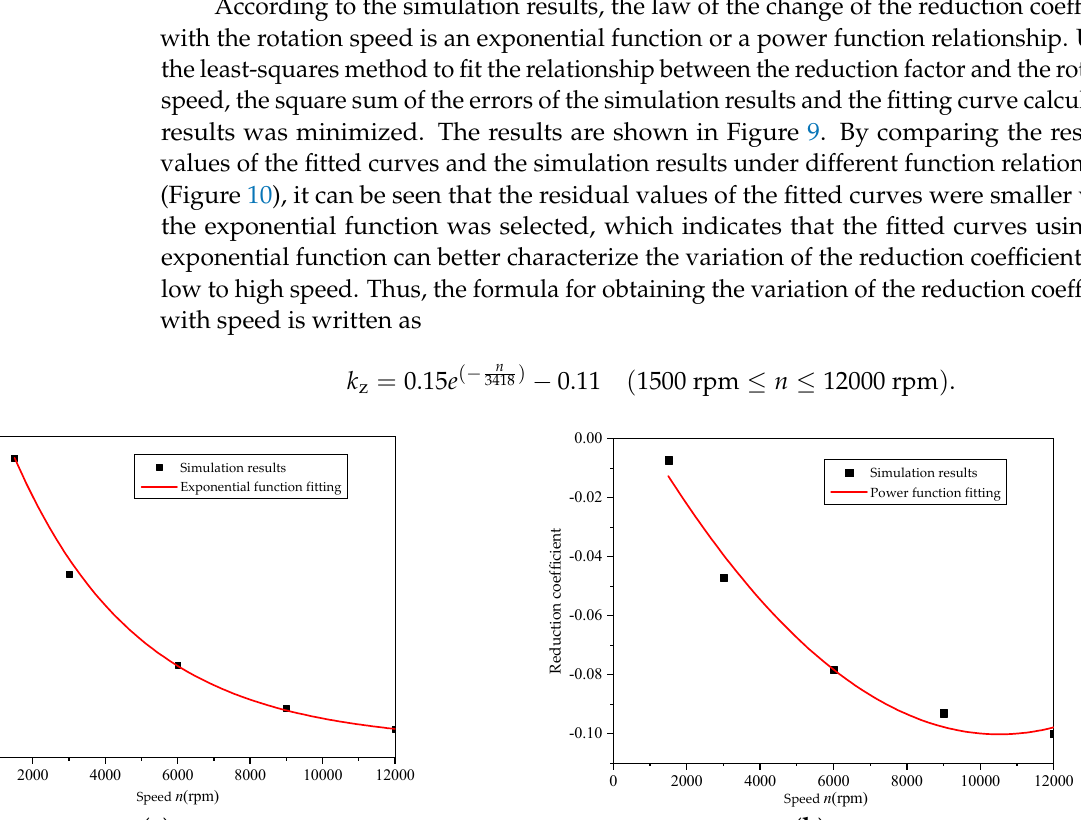
( b ) Figure 10. Residuals of different fitting curves: ( a ) exponential function fitting and ( b ) power function fitting. Thus, the expression of churning losses due to the multi-pistons from the fitting curve calculation results P pm ’ can be expressed as: (